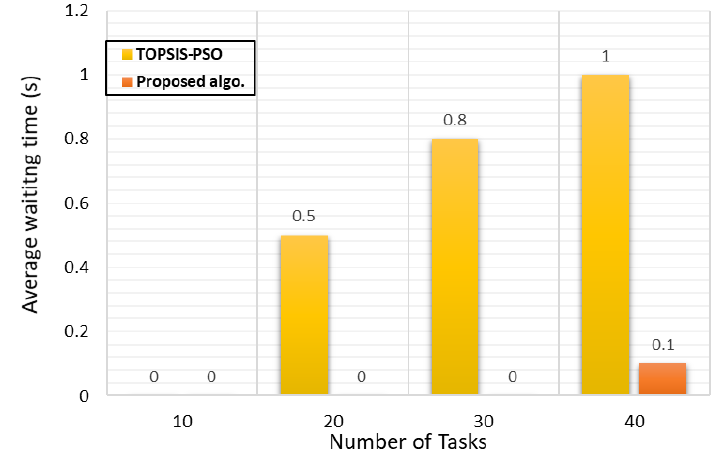
Figure 6. Average waiting time.